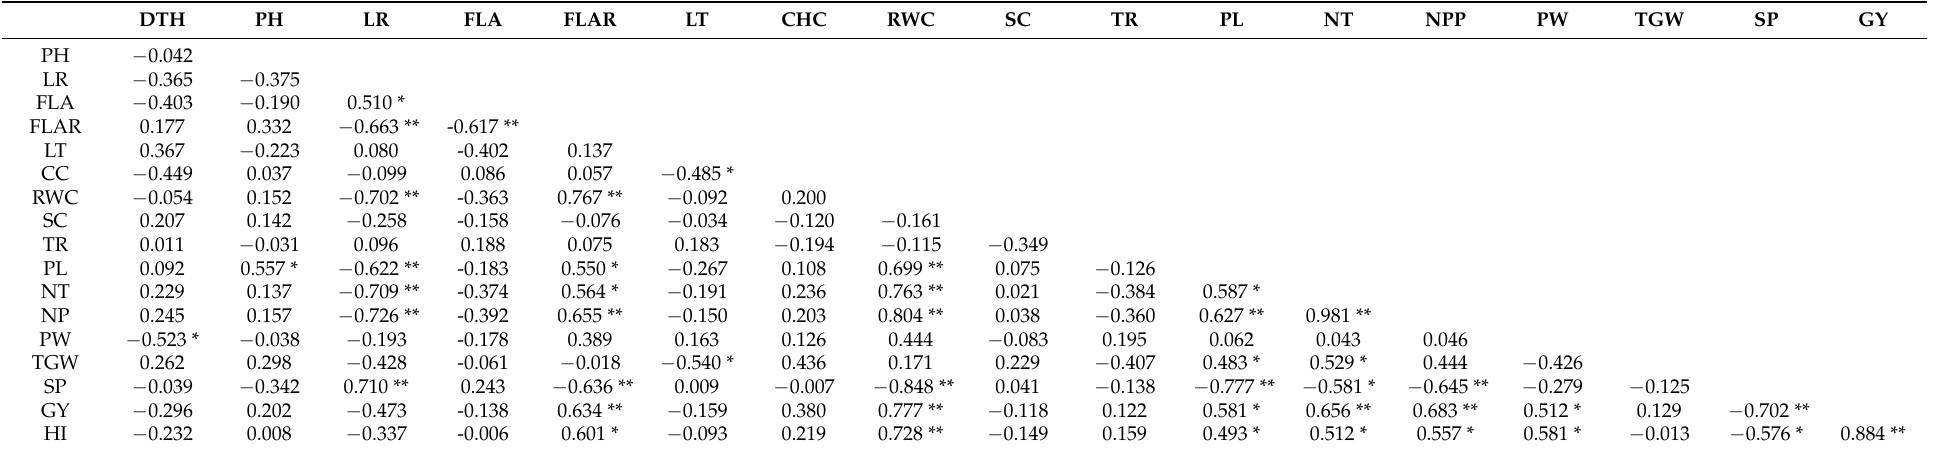
Table 8. Pearson correlations showing the strength of relationships of all observed parameters under water-deficit treatment